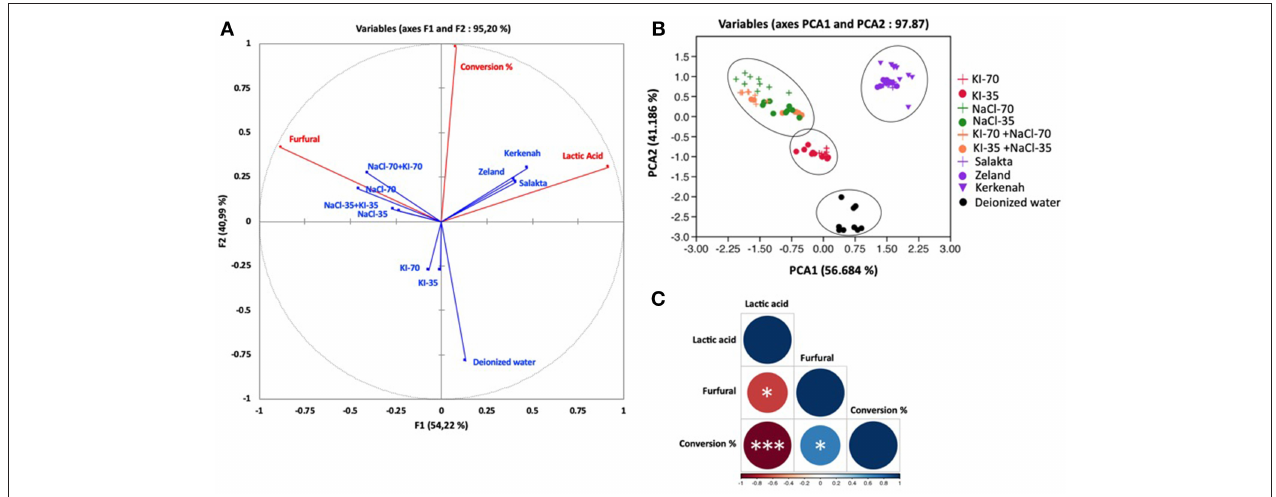
FIGURE 8 | Principal component analysis of molar conversion of D-xylose and its molar conversion efficiency into furfural and lactic acid under different salts concentration and seawater treatment. (A) Correlation circle: red lines represent parameters (active variables) and blue lines show the treatments (supplemental variables), (B) Observations, and (C) correlation plot. * P < 0.05; *** P < 0.001.